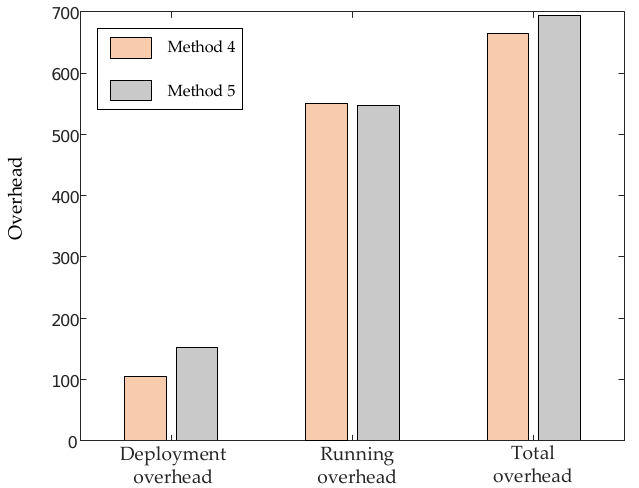
Figure 9. Comparison of network overhead between method 4 and method 5.